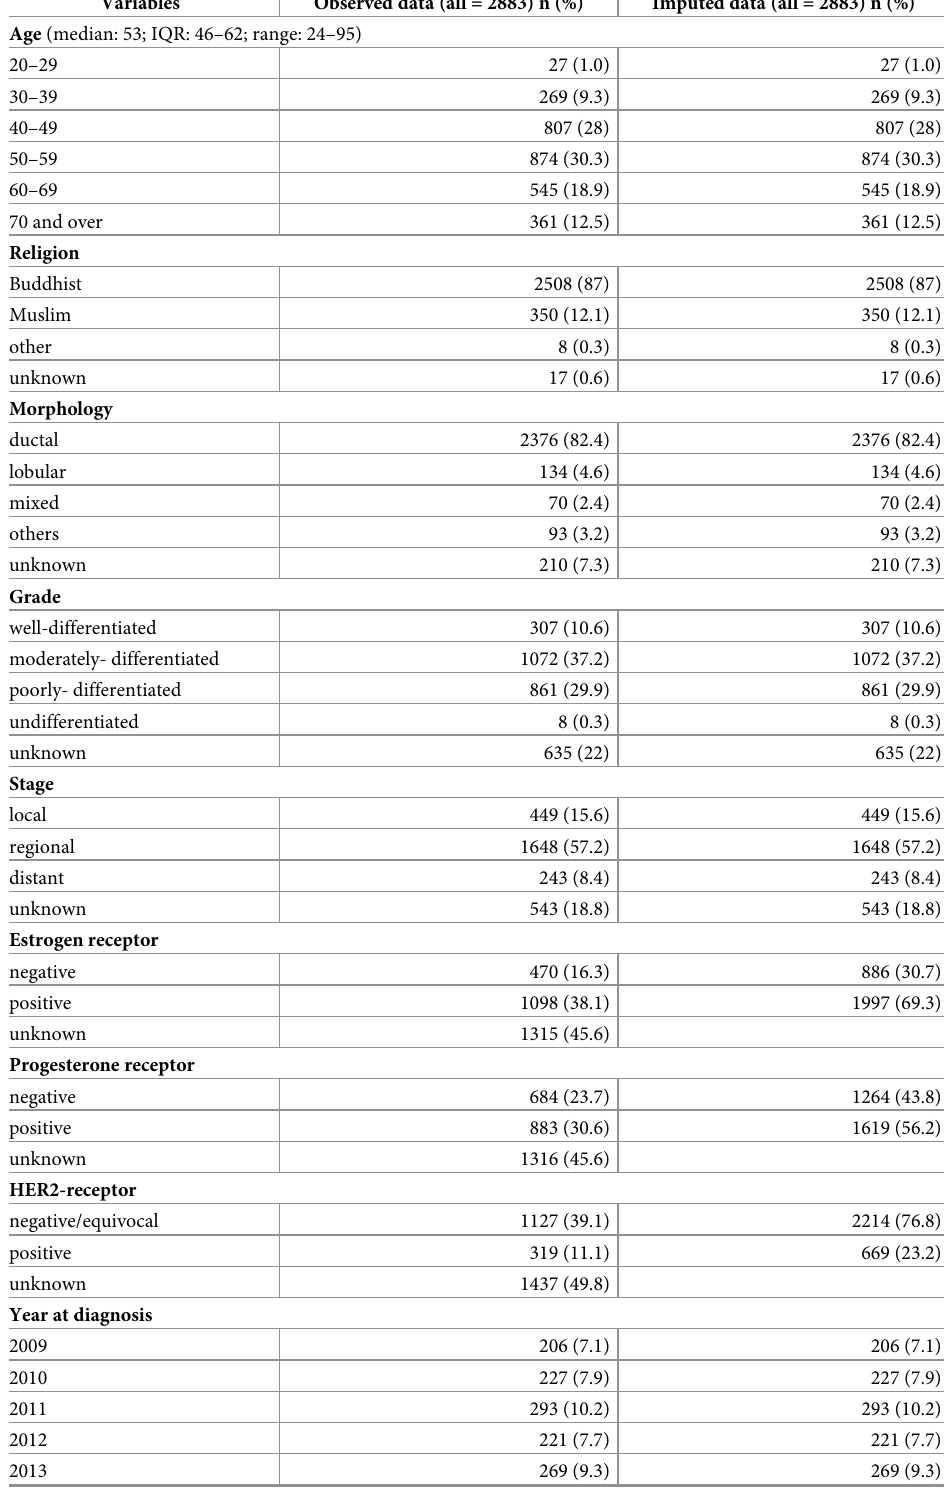
Table 1. Demographic and tumor characteristics of observed and imputed